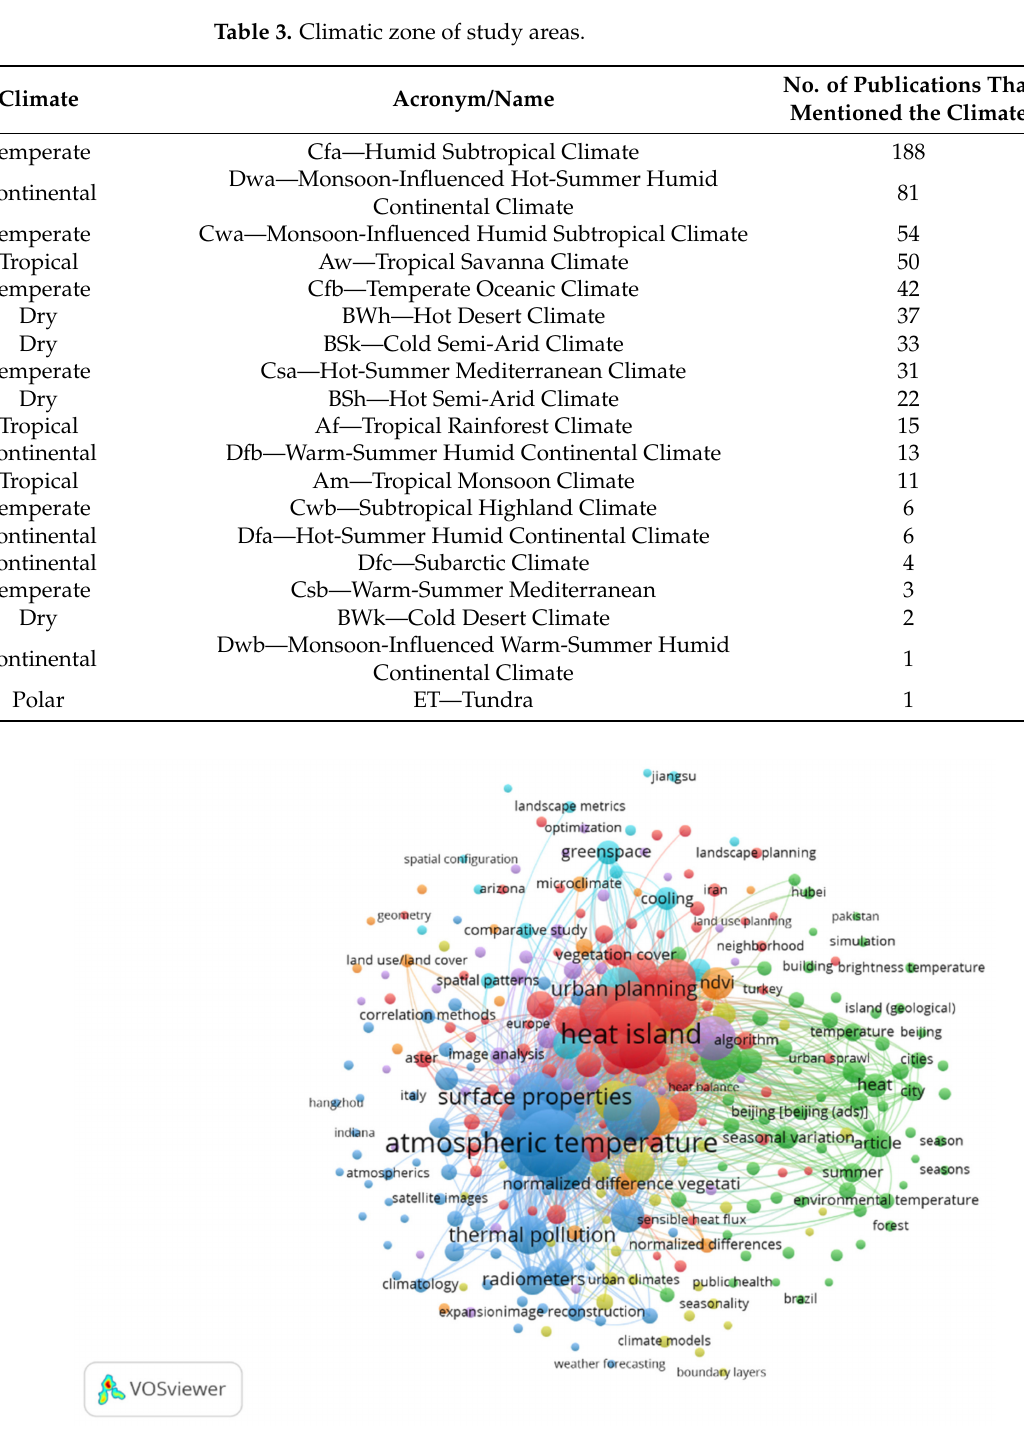
Figure 6. Most used keywords in the